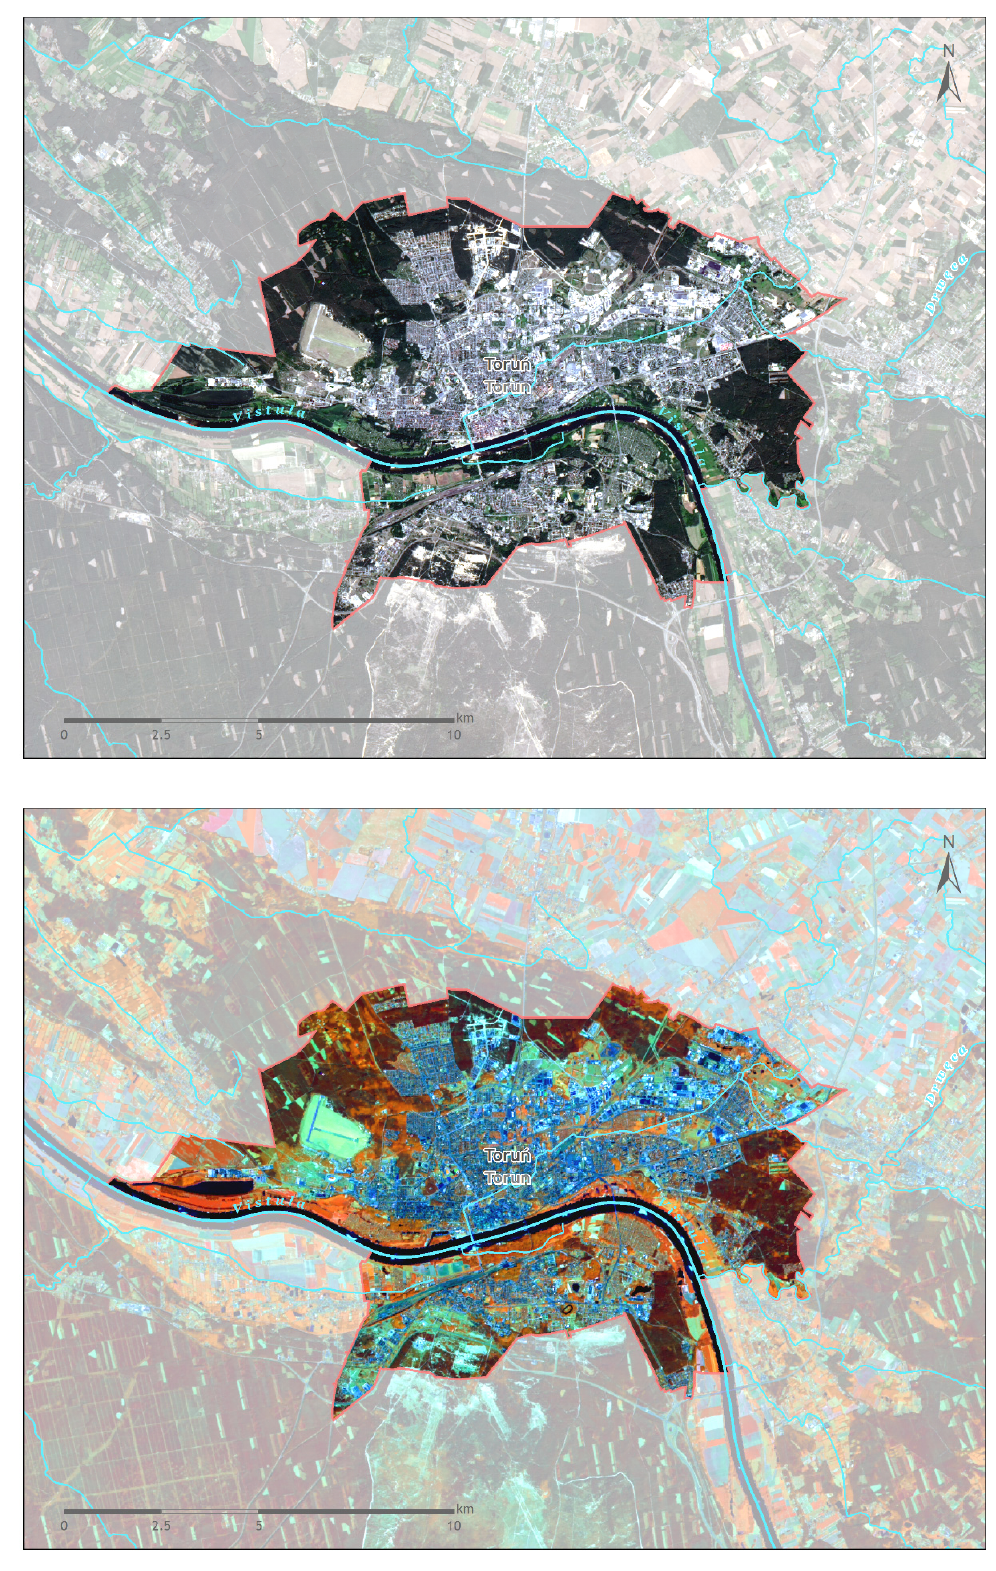
Figure 4. Landsat 9 OLI-2 multispectral images from July 2022, in natural colors (above) and false colors (NIR-SWIR1-RED, below; the strong hues of blue represent the urban/construction areas, while the vegetation areas are in light brown), 15 m resolution, of Torun and its Vistula stretch, Poland. Data source: https://earthexplorer.usgs.gov/ [28] (accessed on 11 August 2022).